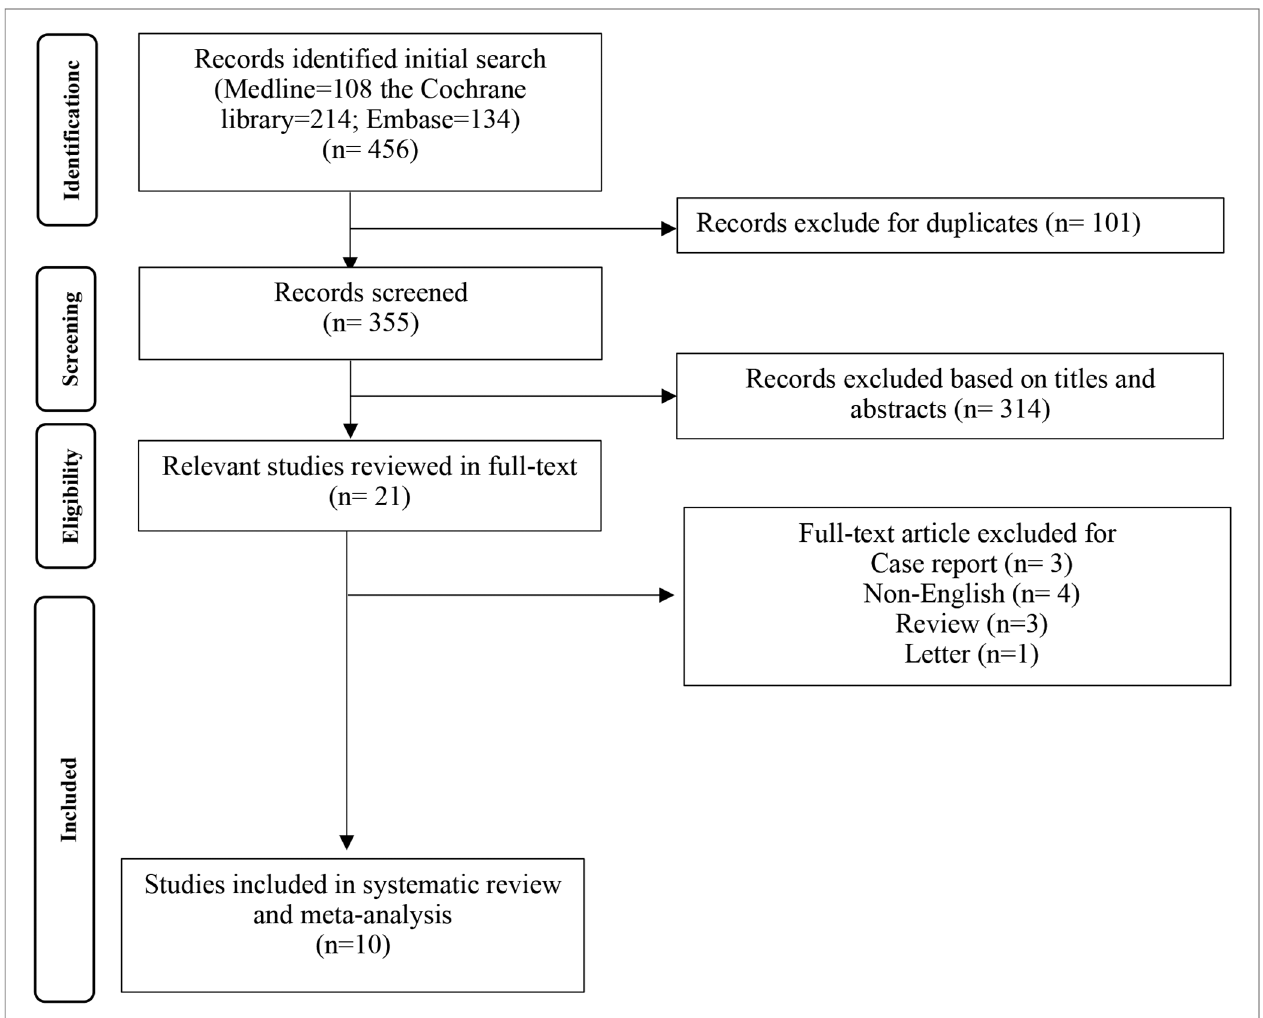
FIGURE 1 | Process of study